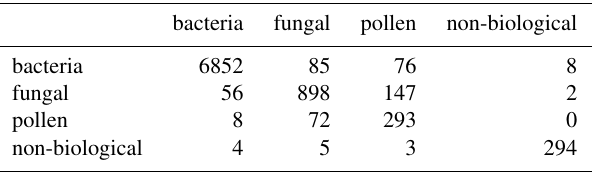
Table 11. Matching matrix for the worst case scenario when using gradient boosting. This is when using 9 σ on 2008